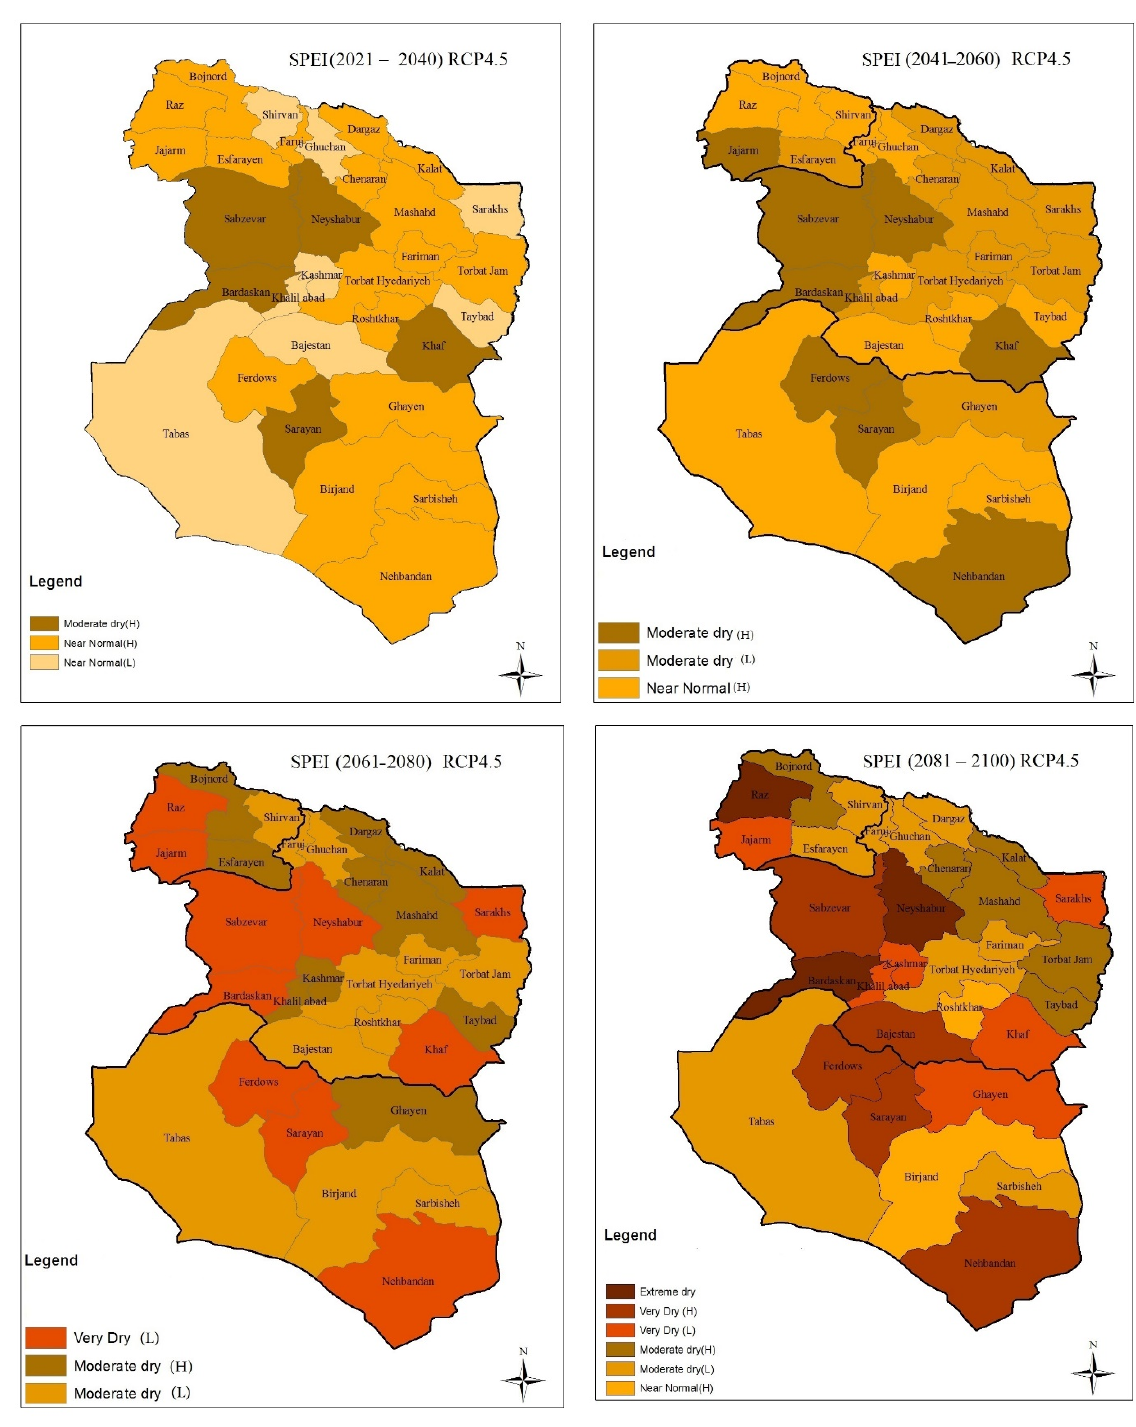
Figure 6. Future drought projection over study region using SPEI under RCP4.5 scenarios